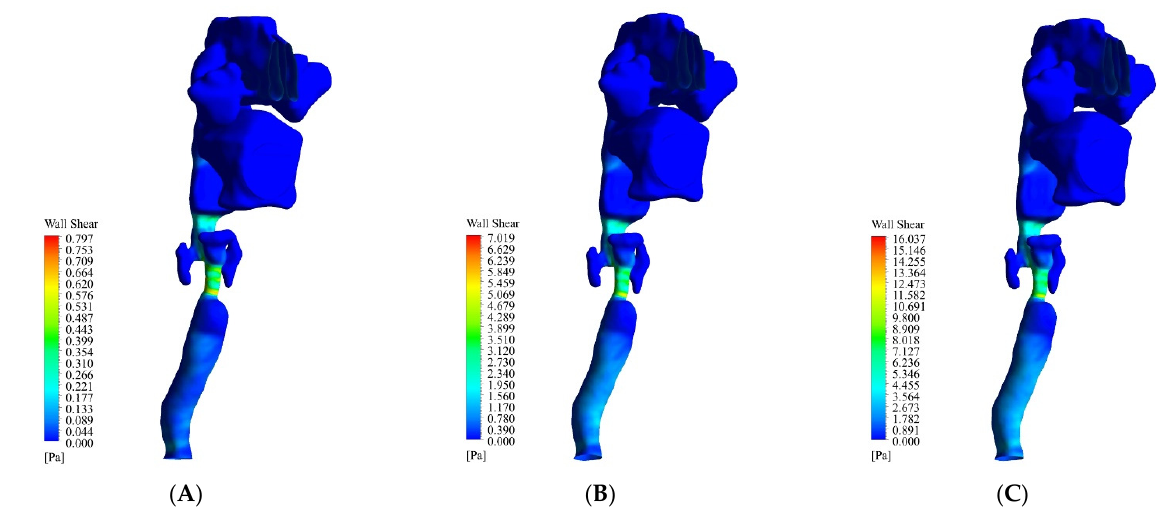
Figure 6. The WSS changes at flow rates of 13 L/min, 55 L/min, and 100 L/min. ( A ) 13 L/min. ( B ) 55 L/min. ( C ) 100 L/min.